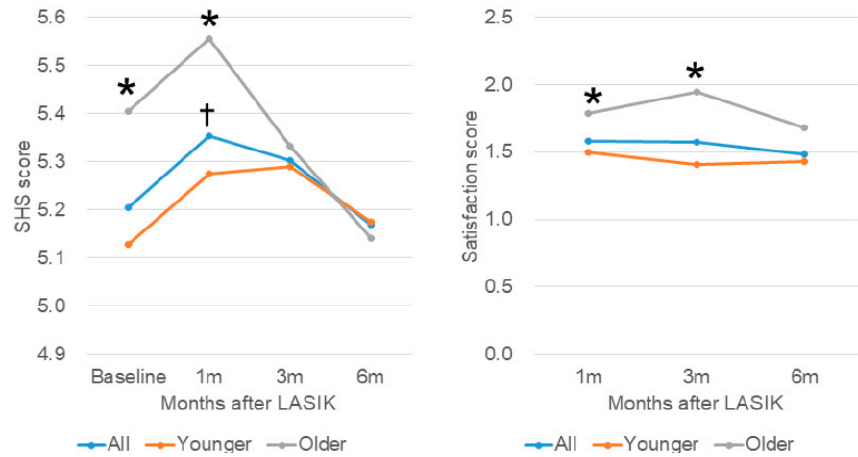
Figure 1. Subjective happiness score (left) and satisfaction scores (right) in patients stratified by age. (Left) Mean Subjective Happiness Score (SHS) of all participants (blue symbol) peaked at one month after surgery ( † p = 0.002, vs. baseline), but then decreased at three months ( p = 0.999) and returned to baseline at six months ( p = 0.999). SHS was greater in the older group (grey symbol) compared with the younger group (red symbol) at baseline ( * p = 0.005) and at one month ( * p < 0.001), but were similar at three months ( p = 0.155) and at six months ( p = 0.103). (Right) Mean satisfaction score of all participants (blue symbol) improved slightly but did not reach statistical significance. Satisfaction score was significantly worse in the older group (grey symbol) than the younger group (red symbol) at one month ( * p = 0.003), at three months ( * p = 0.017), but not at six months ( p =